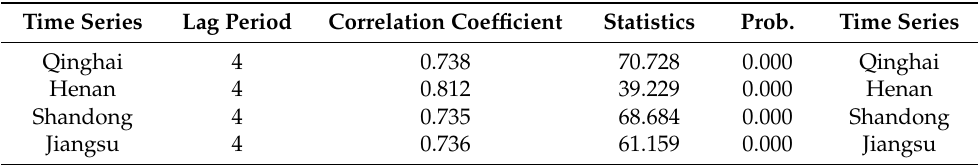
Table 1. Cyclicity test results of original time series data.